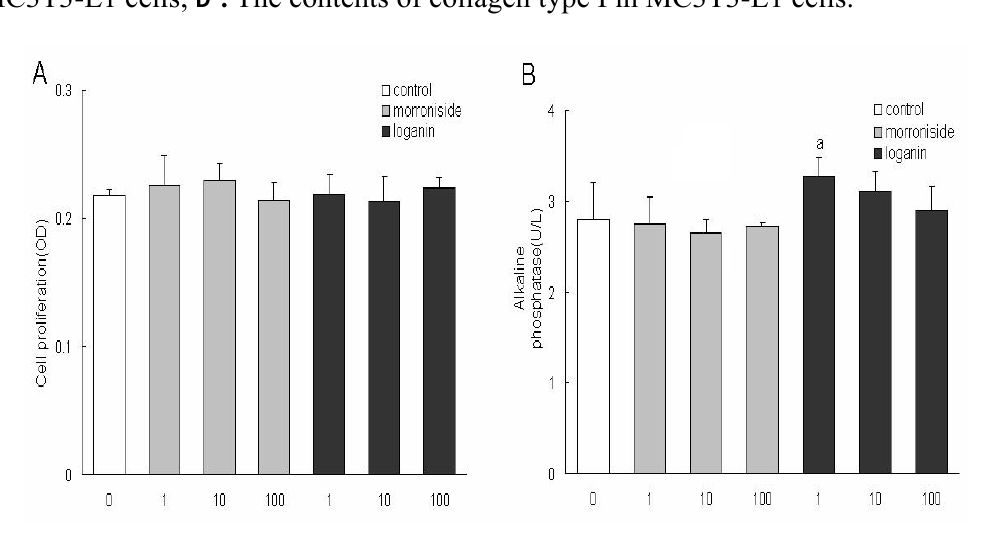
Figure 1. A. The effects of morronside and loganin on the proliferation of MC3T3-E1 cells. Cells were cultured with medium containing different concentrations (1, 10, 100 μ g/mL) of the two constituents for 96 h and the viability of cells was measured by MTT method; B: The activity of ALP in MC3T3-E1 cells; C: The contents of osteocalcin in MC3T3-E1 cells; D: The contents of collagen type I in MC3T3-E1